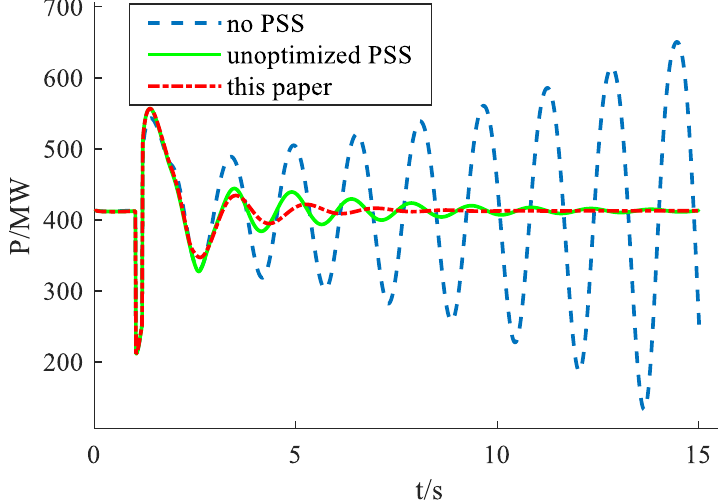
Figure 11. Active power output of tie-line.